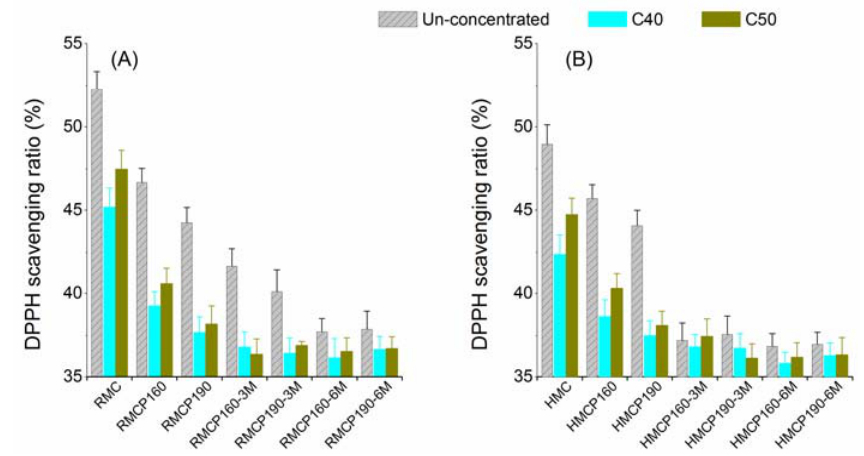
Figure 2. DPPH scavenging ratio ( A and B ) and peroxide value ( C and D ) of